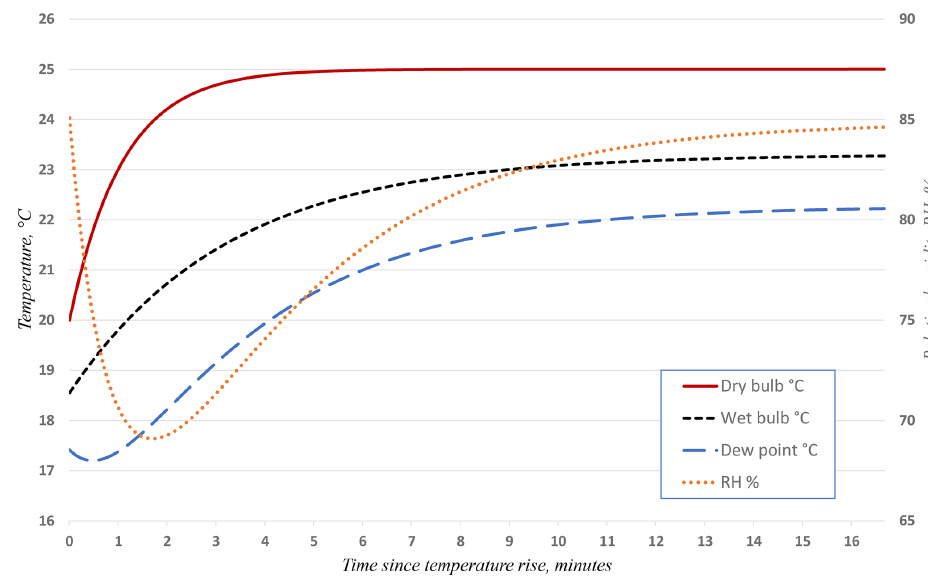
Figure 10. The same as Fig. 9 but for an instantaneous rise in temperature of 5K from 20 ◦ C. Table 3. Tabulated 60s running mean values for each minute (the average of the preceding 6 × 10s sampled values) following an instantaneous reduction in dry-bulb temperature from 20 to 15 ◦ C at t = 0 and a nominal wet-bulb temperature, assuming response times as for the dry- and wet-bulb thermometers in Table 2. All values are given to one decimal place. Note that the nominal wet-bulb temperature is above the dry-bulb temperature until after t =